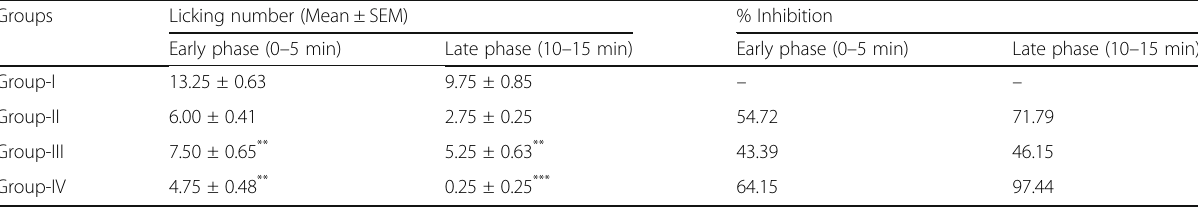
Table 5 Effect of methanolic extract of the L. sativus L. seeds on formalin induced writhing in mice Groups